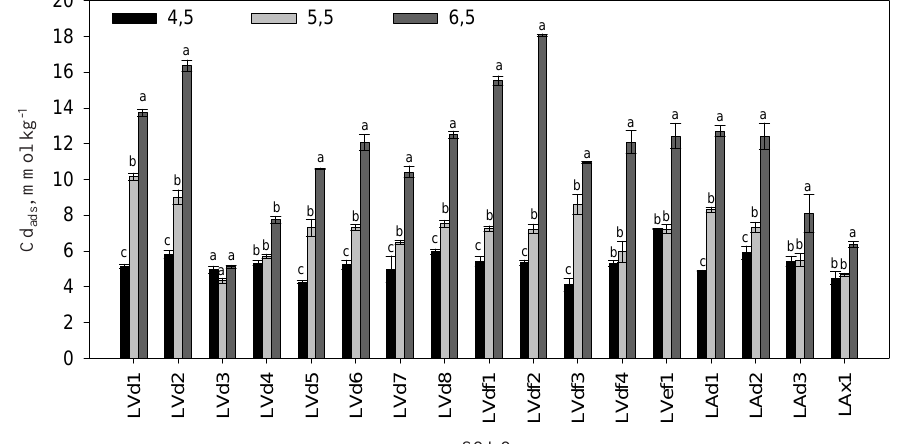
Figura 1. Cádmio adsorvido (Cd ) por amostras do horizonte A de 17 Latossolos brasileiros, em três ads valores de pH da solução de equilíbrio. [Concentração inicial de Cd = 0,20 mmol L -1 ; solução de equilíbrio = Ca(NO ) 5 mmol L -1 ; relação solo:solução final: 1:100]. (LVd = Latossolo Vermelho distrófico 3 2 típico; LVdf = Latossolo Vermelho distroférrico típico, LVef = Latossolos Vermelho eutroférrico típico; LAd = Latossolo Amarelo distrófico típico; LAx = Latossolo Amarelo coeso). Médias (teste de Scott- Knott 5 %) seguidas por letras minúsculas comparam cada solo de acordo com o pH. Barras de erro indicam o desvio-padrão (n =